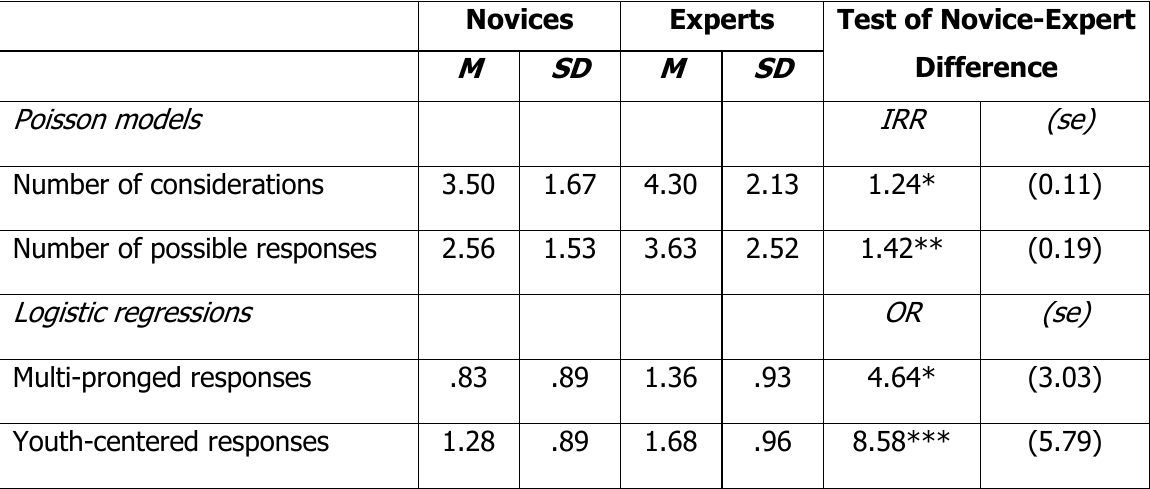
Comparison of experts ‘versus novices’ descriptions of their considerations and responses for the dilemma situations presented in the vignettes Novices Experts Test of